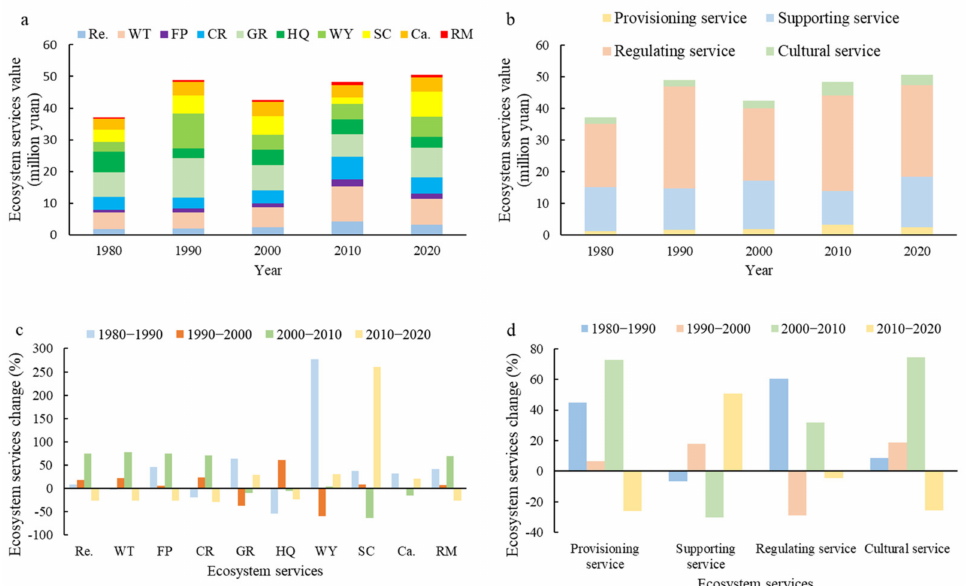
Figure 3. The temporal variability and change rate of ecosystem services (ESs) in the Yellow River Delta (YRD) from 1980 to 2020. ( a , b ) The temporal variability of ESs in the YRD from 1980 to 2020. ( c , d ) The change rate of ESs in the YRD from 1980 to 2020. (FP: food production, RM: raw material, SC: soil conservation, Ca.: carbon storage, HQ: habitat quality, GR: gas regulation, CR: climate regulation, WY: water yield, WT: waste treatment, Re.: relaxation.)